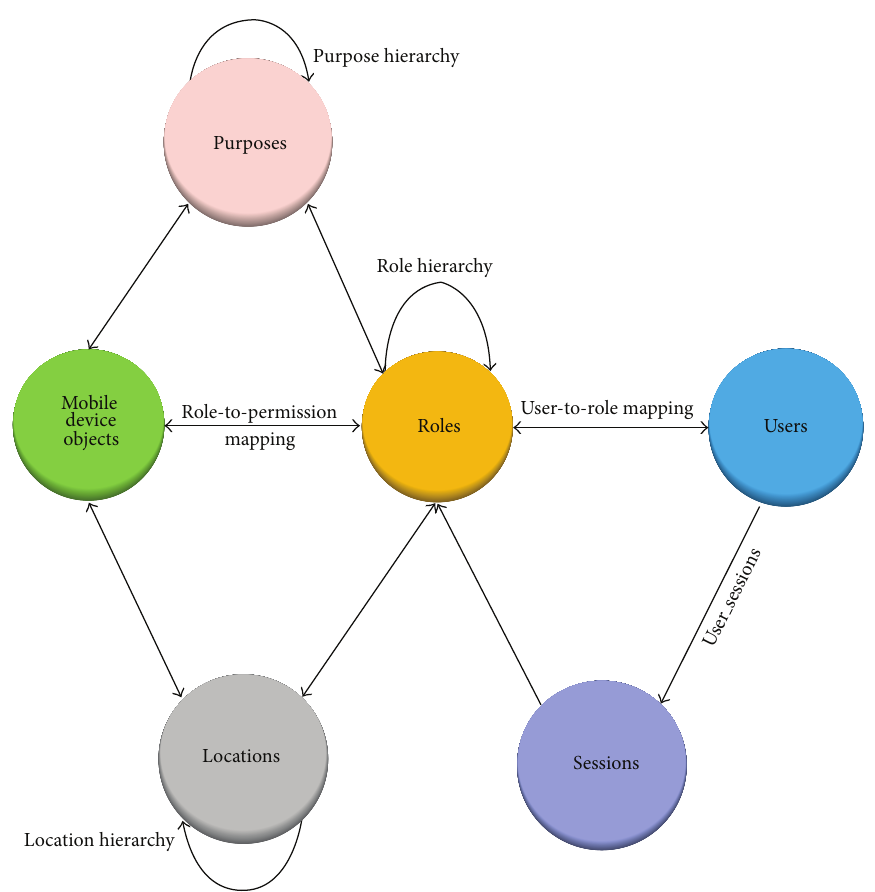
Figure 1: Contextual role-based access control model.